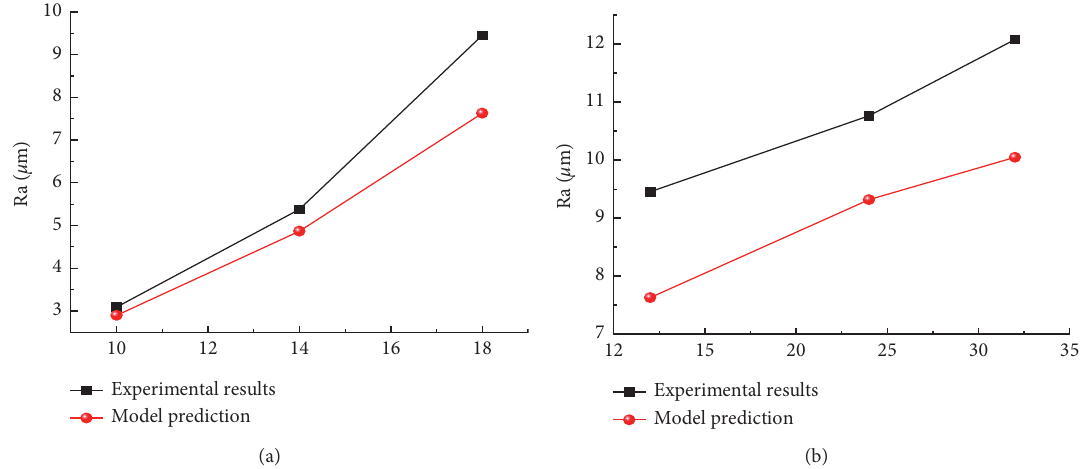
Figure 7: The relationship between (a) peak current and surface roughness and (b) pulse width and surface roughness. (a) Peak current (A); (b) pulse width ( μ